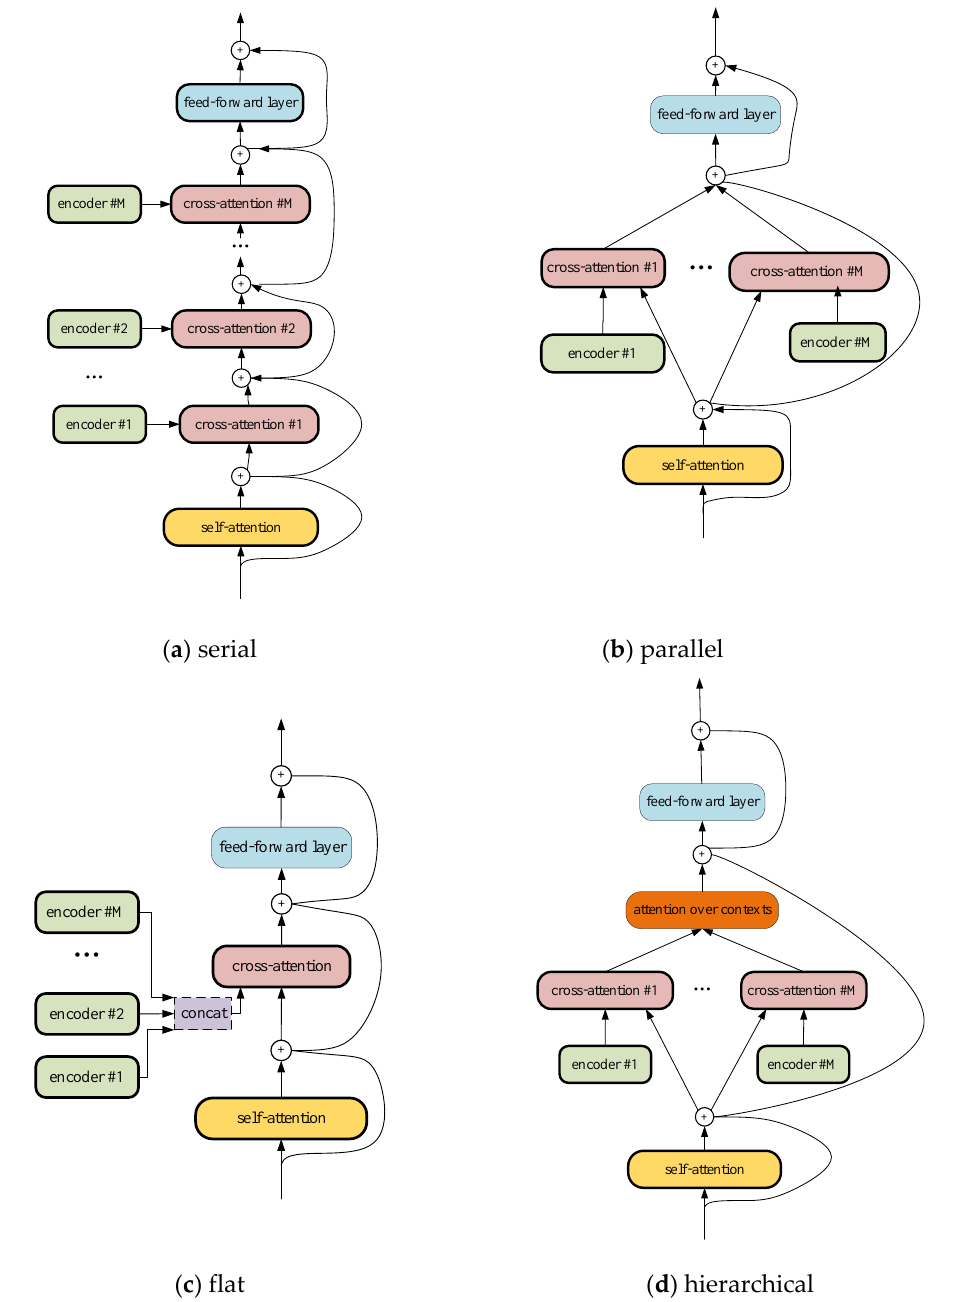
Figure 2. Four combination strategies: ( a ) serial, ( b ) parallel, ( c ) flat, and ( d ) hierarchical.